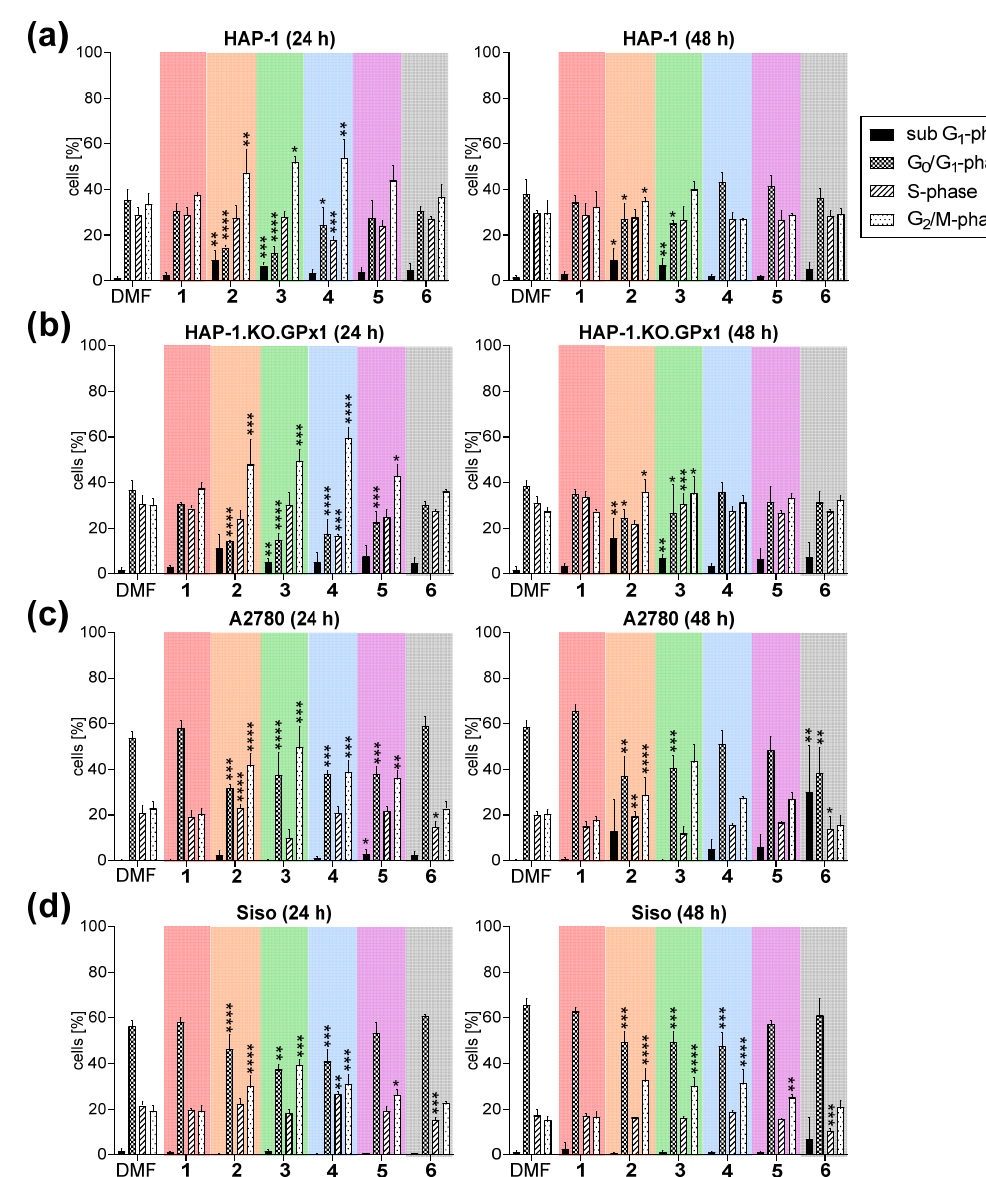
Figure 18. Distribution of cell cycle phases in HAP-1 ( a ), HAP-1.KO.GPx1 ( b ), A2780 ( c ), and Siso ( d ) after a treatment for 24 (left) and 48 h (right) with the respective pentathiepin (IC 90 ) or the solvent DMF as negative control. Representative histograms are provided in Figure S46. The fractions of cells in either sub G 1 -, G 0 /G 1 -, S-, or G 2 /M-phase are displayed as mean and SD. Asterisks indicate differences between the solvent control and the treatment condition. Statistical analysis was performed in Prism 7 by one-way ANOVA and Dunnett’s multiple comparisons post hoc test. n = 3